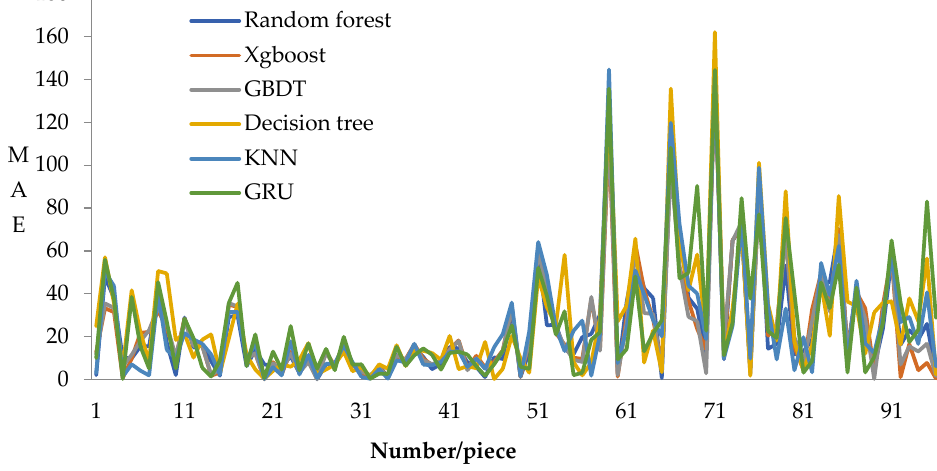
Figure 12. The error graphs of different models.